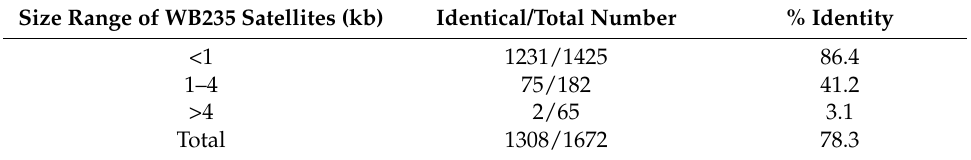
Table 1. Comparison of satellite lengths in the WB235 (Sanger) and VC2010 (Nanopore)